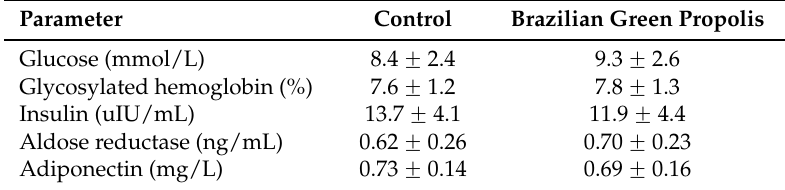
Table 3. Effects of Brazilian green propolis on glucose metabolism in T2DM patients.